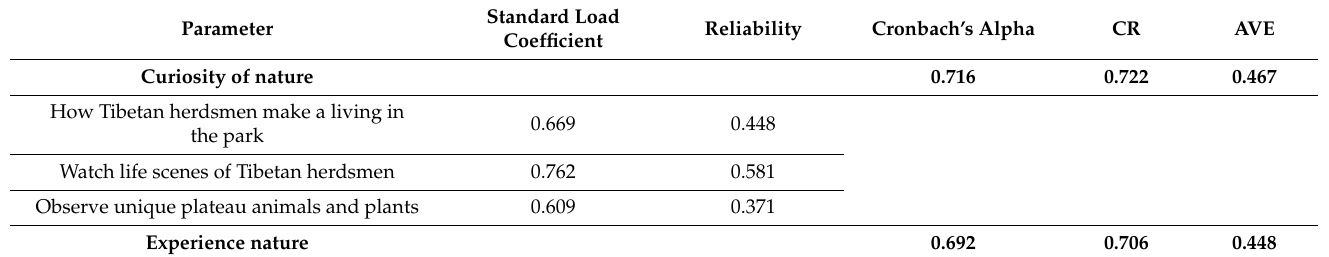
Table 5. Parameters of item confirmatory factor